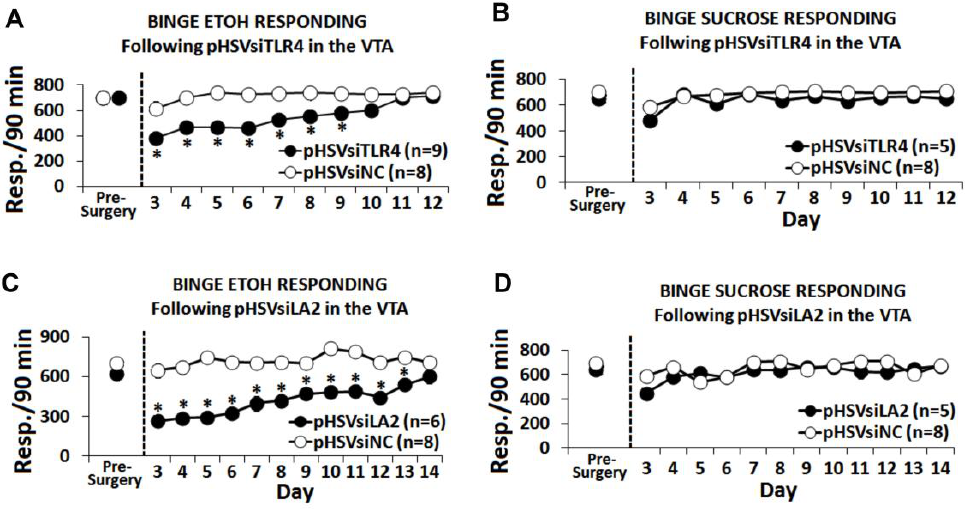
Figure 5. The α2/TLR4 signal in the VTA regulates binge alcohol drinking. pHSVsiTLR4 ( A )